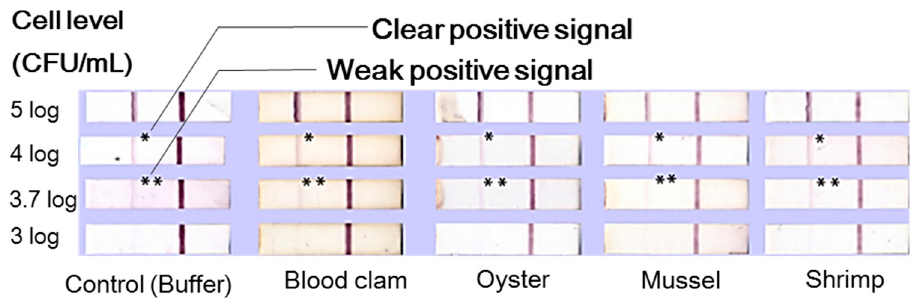
Figure 10. Detection of Vibrio cholera O139 using a lateral-flow, immunochromatographic strip conjugated to a gold nanoparticle. Adopted and reproduced from Pengsuk et al. [84] with permission from Elsevier.